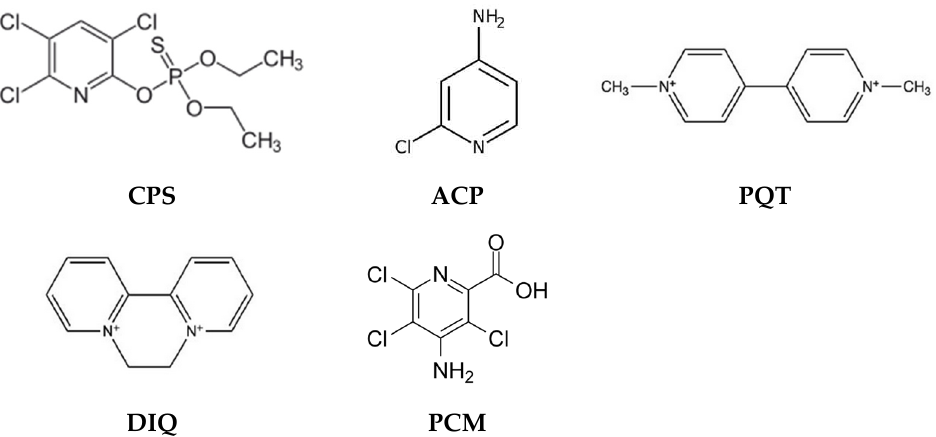
Figure 2. Structures of pesticides removed by PIMs. Table 2. Examples of removal of pesticides by